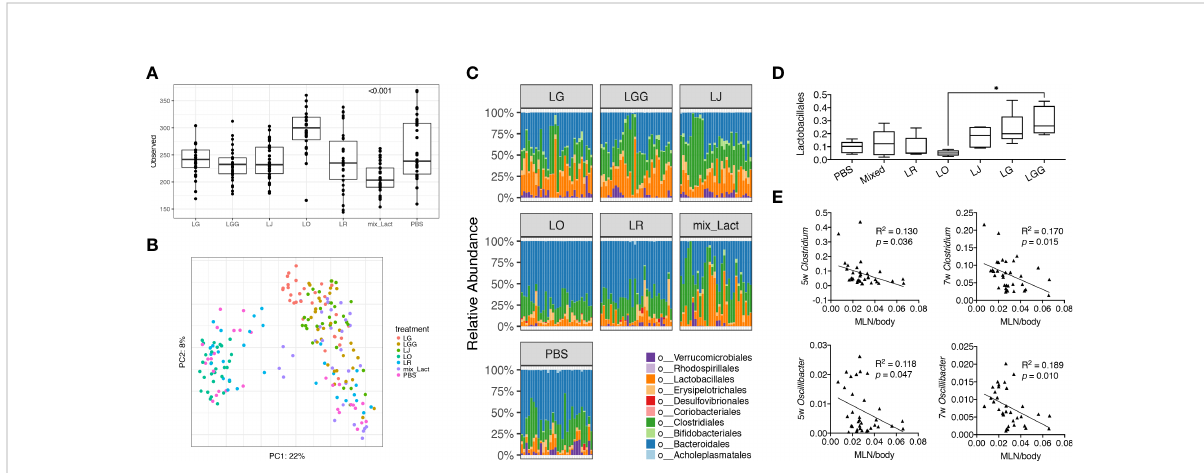
FIGURE 2 Gut microbiota at early stage is associated with the decrease of gut-draining lymph node size. Fecal microbiota samples were collected at 3, 5, 7, 9, 11 and 13 weeks of age (n=5 mice per group) and subjected to 16S rRNA sequencing. (A) Observed OTUs ( p <0.001). (B) Principal coordinate analysis of fecal microbiota composition. (C) Time-dependent changes of fecal microbiota at the order level. (D) The relative abundance of the order Lactobacillales . Statistical signi fi cance (* p <0.05) is shown based on one-way ANOVA. (E) Correlation analysis of the relative abundance of the genera Clostridium and Oscillibacter at 5 and 7 weeks of age against the MLN-to-body weight ratio at 15 weeks of